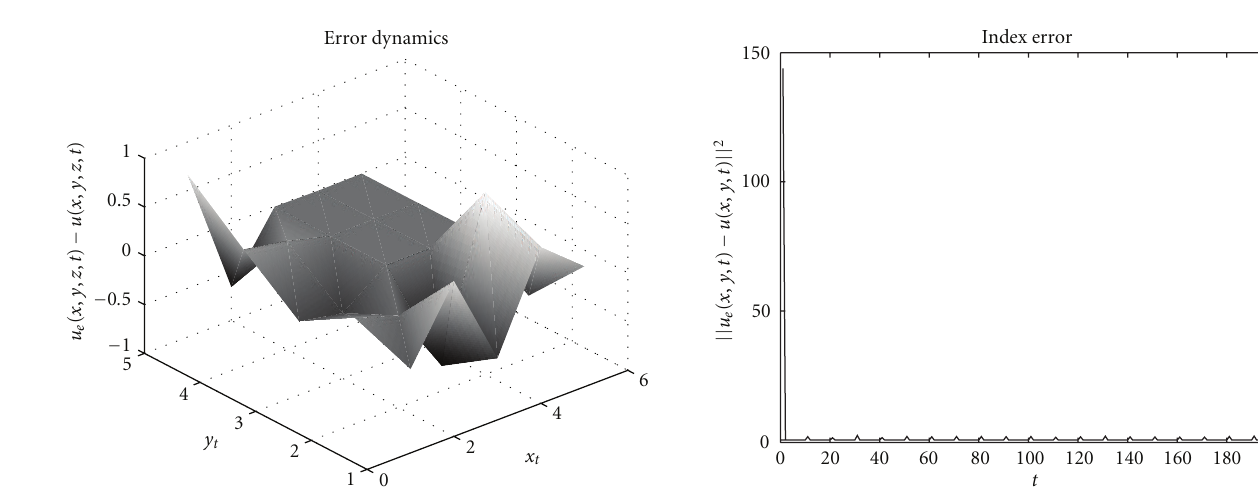
Figure 10: Index quadratic error for the whole time with coordi- nates x , y , and z